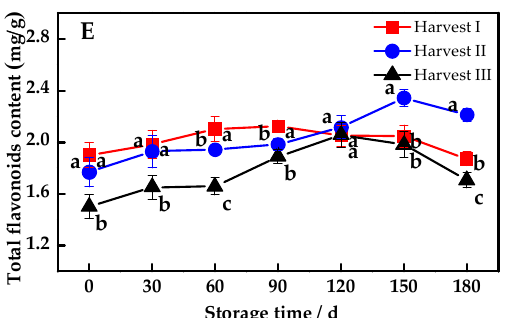
Figure 1. Dynamic changes for the antioxidant substance of Majiayou pomelo (MP) during storage at ambient temperature. ( A ) Changes for the ascorbic acid content; ( B ) Changes for the lycopene content; ( C ) Changes for the carotenoid content; ( D ) Changes for the total phenols content; ( E ) Changes for the total flavonoids content. The different letters for the same storage time indicates a significant difference ( p < 0.05).